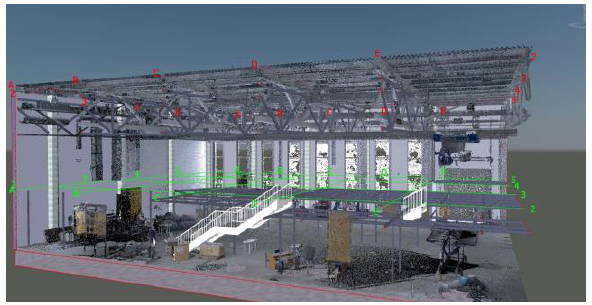
Figure 9. Navisworks assembly: as-built BIM-model of the